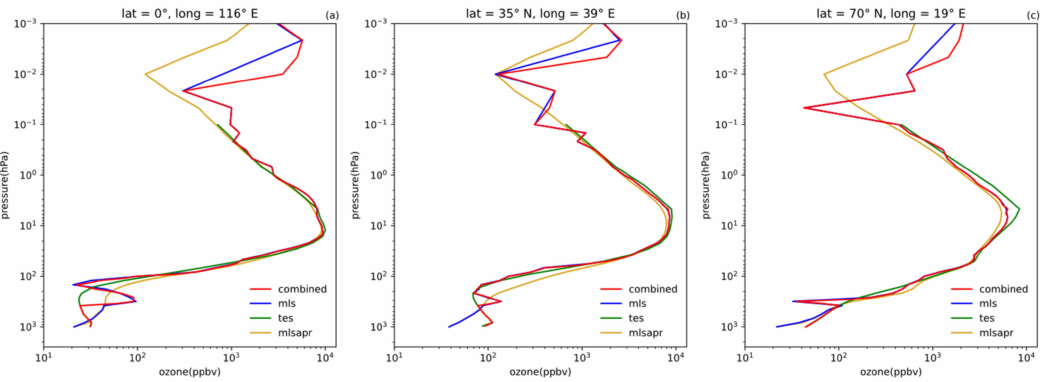
Figure 4. Comparison among ozone vertical profiles of combined profiles (red), MLS profiles (blue), TES profiles (green), and MLS a priori profiles (yellow) at ( a ) (116 ◦ E, 0 ◦ ), ( b ) (39 ◦ E, 35 ◦ N) and ( c ) (19 ◦ E, 70 ◦